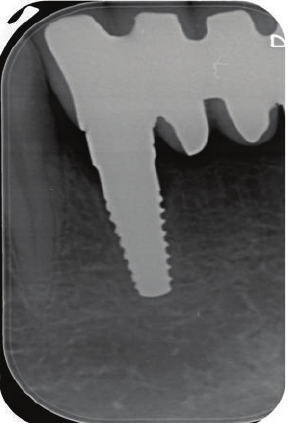
Figure 13: Radiographic control 4 years after implant insertions.